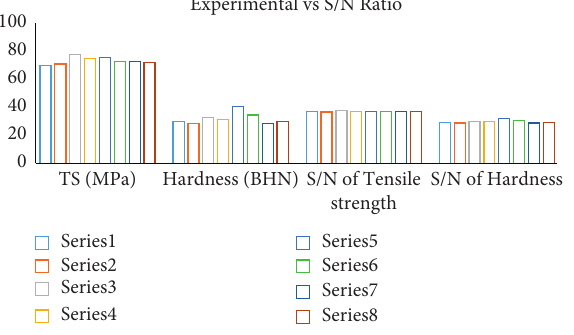
Figure 6: Experimental versus S/N ratio.